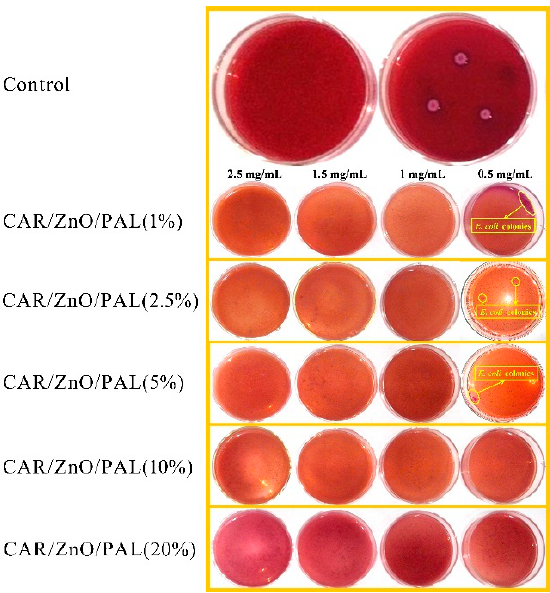
Figure 10. MIC evaluation of ZnO/PAL at different concentrations of CAR against E. coli .